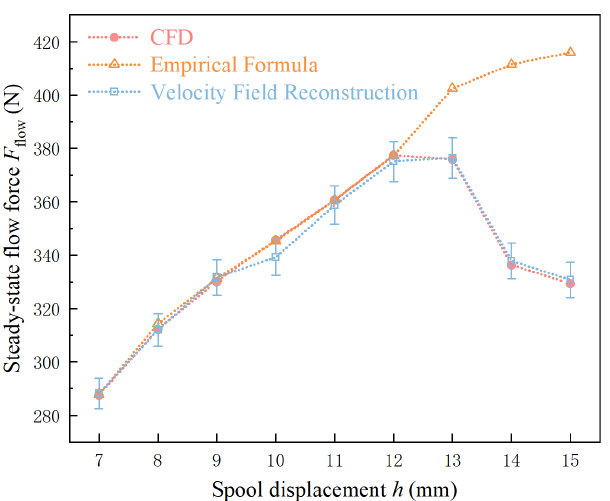
Figure 15. Comparison of the results of different steady-state flow force calculation